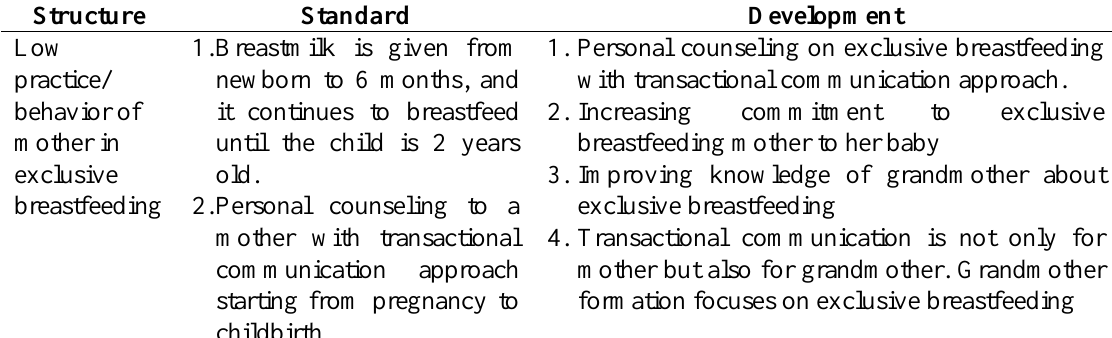
Table 8. Development of Transactional Communication Model between midwife and postpartum